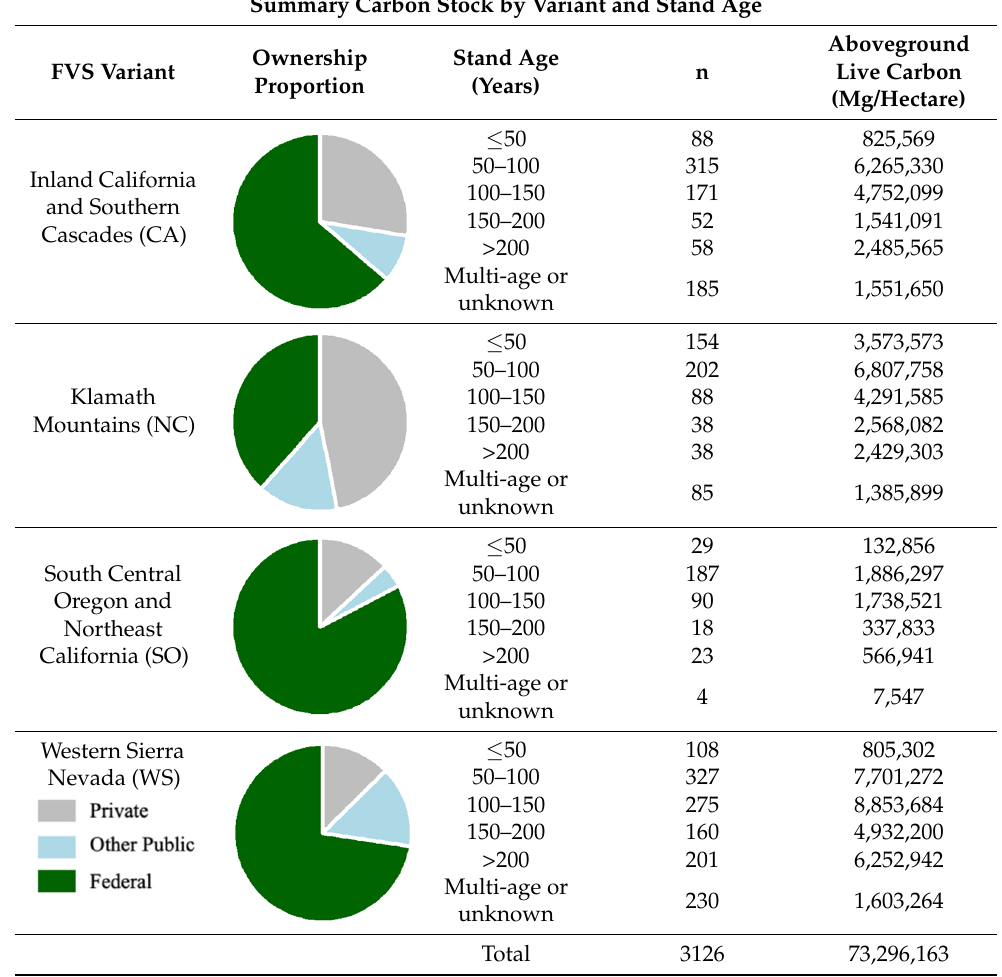
Table 1. Live tree carbon stocks observed at the remeasurement visit and flux calculated as stock change between the installation and remeasurement visits, computed using FIA’s system of allometric models for tree carbon for trees observed, at both visits, to be live and growing on land classified as forest, by stand age class and variant, and proportions of carbon stocks by owner group (dark green is national forest, light blue is other public, and grey is private).